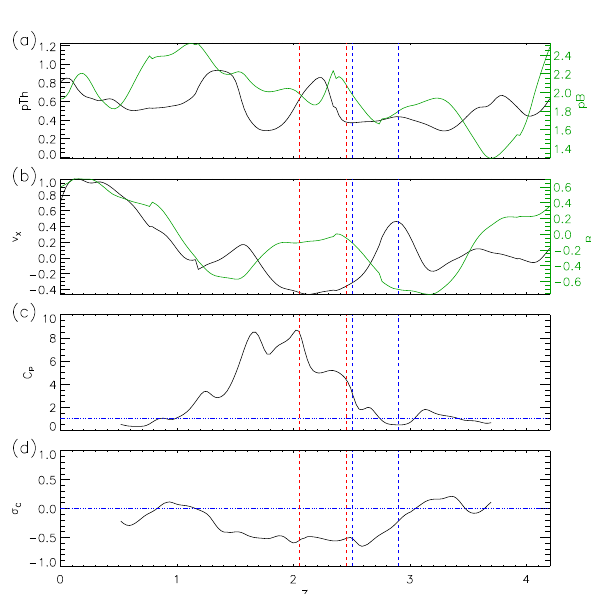
Figure 6. Features of points near density maximum in case 1, at t = 0 . 71. (a) Instant values of thermal pressure p th = ρT (black) and magnetic pressure p B = B 2 / 2 (green). (b) Instant values of perpendicular components of velocity v x (black) and magnetic field B x (green). (c) Compressibility C computed with Eq. (11b). (d) Di- mensionless cross-helicity σ c computed with Eq. (11a). Horizontal axes represent the z coordinate along the slice, which is taken at x = 4 . 10, y = 3 . 14, and 0 ≤ z < 4 . 2. In (a) and (b) , both vertical axes are adjusted so that they share the same scale. Red lines mark “wave points”, and the vertical blue lines mark a region of negative correlation of v x and B x